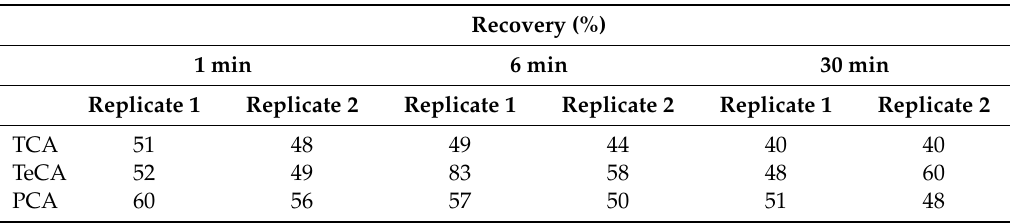
Table 3. Recoveries obtained from 100 mL of fortified hydroalcoholic solutions, by eluting them with dichloromethane after a drying step of 1, 6 or 30 min.